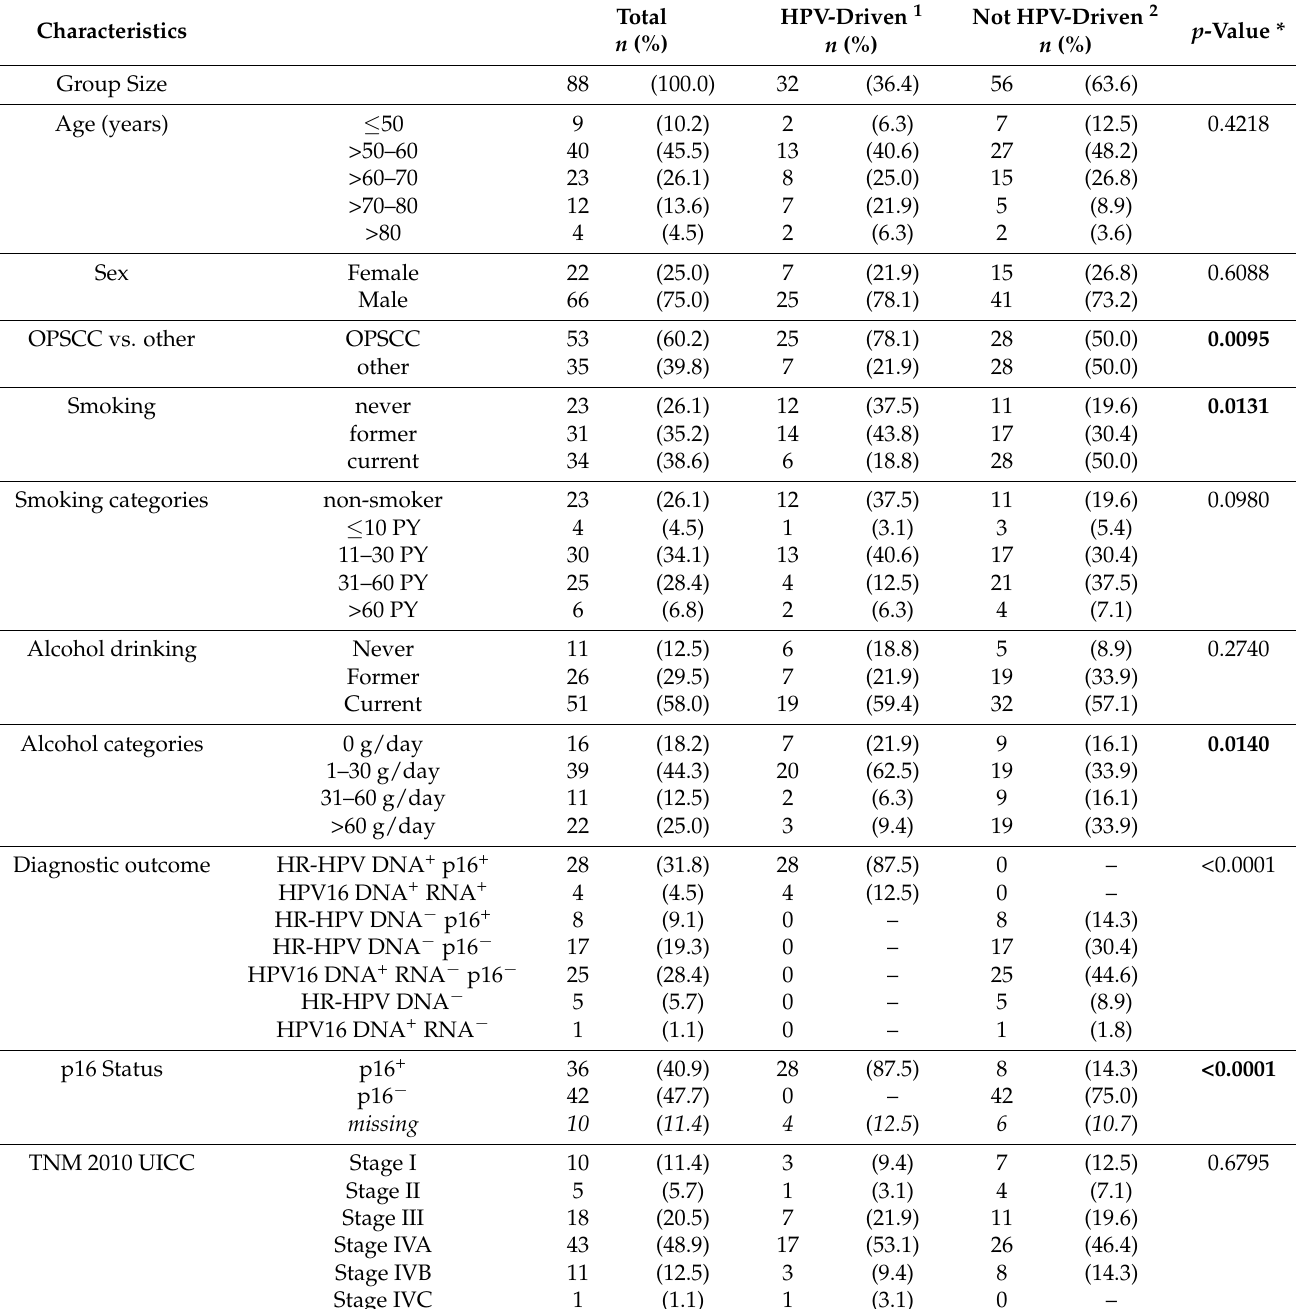
Table 1. Characteristics of patients included in this